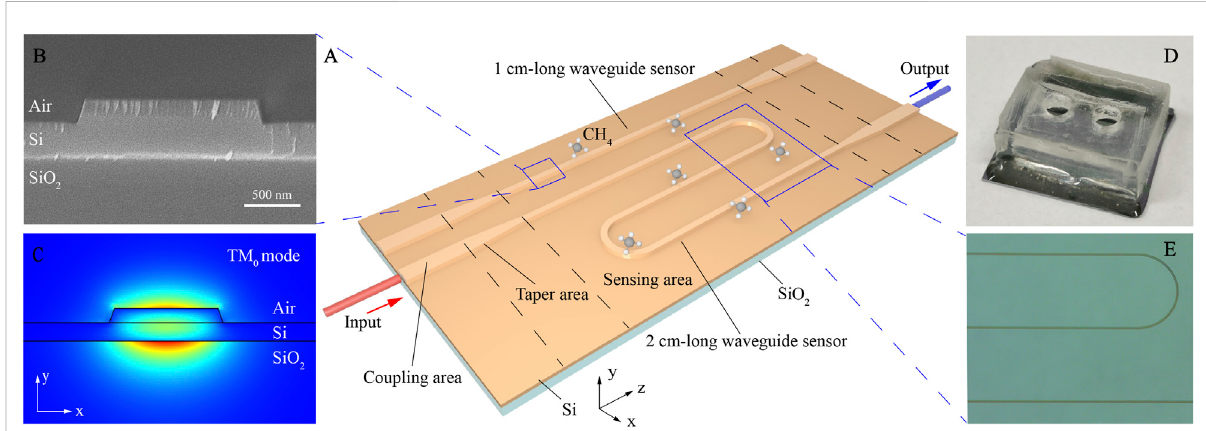
FIGURE 1 (A) Schematic of the SOI ridge optical waveguide sensor chip, which is composed of sensing area, taper area and ridge waveguide at both ends forcouplingwithoptical fi ber.Therearetwowaveguidesensorsonthechip:astraightwaveguidesensorwithalengthof1 cmandabendwaveguide sensor with a length of 2 cm. (B) SEM image of the cross section of a fabricated SOI waveguide. (C) The simulated fundamental TM mode of the SOI waveguide. (D) Photograph of the SOI waveguide with a gas cell. (E) Micrograph of the sensing area.